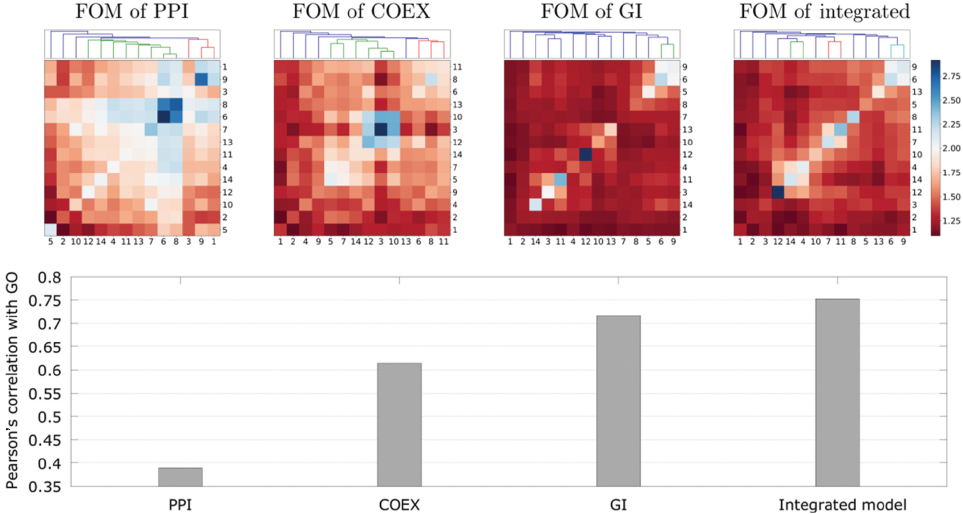
Figure 4: The fit of the functional organization maps obtained from COEX, GI and PPI data to the reference model of functional organization obtained from GO. Y-axis is the value of the Pearson ’ s correlation coefficient between the func- tional organization maps of the interaction data (x-axis) and GO. Above each box plot is the corresponding functional or- ganization map. The correlations for the three data sets are (from left to right): 0.389 for PPI ( p -value 4.02 × 10 − 5 ), 0.614 for COEX ( p -value 3.21 × 10 − 12 ) and 0.717 for GI ( p -value 7.88 × 10 − 18 ). The last point on x-axis shows the fit of the functional organization map of the integrated model of the interaction data with the functional organization map of GO (0.752, p -value ≈ 2.19 × 10 − 20 ). The functions are numbered as in Figure